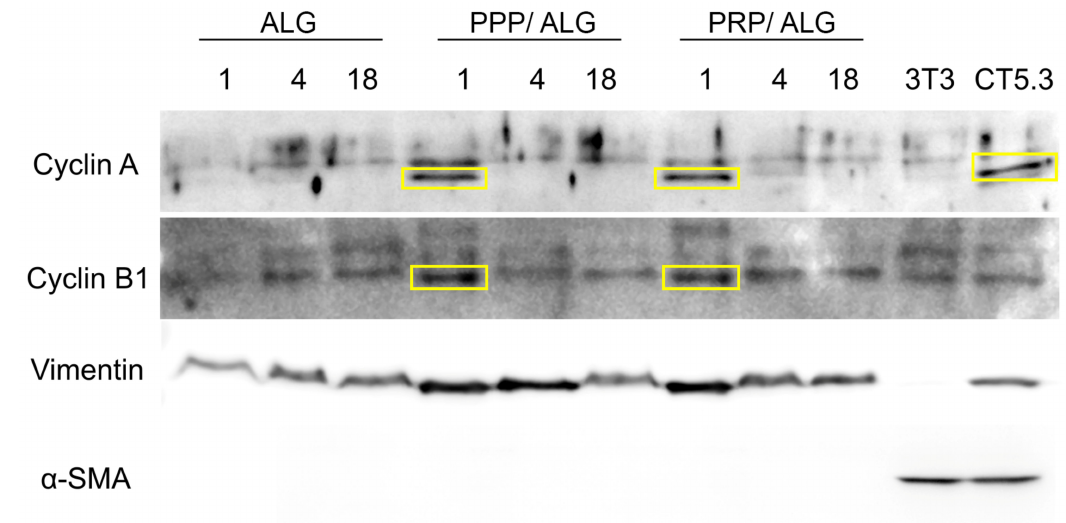
Figure 6. Western blot analysis of protein expression in pristine ALG-, PPP/ALG-, and PRP/ALG-dressing-embedded dermal fibroblasts over time (days 1, 4, and 18). Analysis of the expression of the proliferation markers cyclins A and B1 and the cytoskeletal proteins vimentin and α -SMA. An equal amount of protein was loaded in each lane. Protein extracts of NIH3T3 fibroblasts and CT5.3 colon cancer-associated fibroblasts were used as controls. ALG, alginate; PPP, platelet-poor plasma; PRP, platelet-rich plasma; α -SMA, smooth muscle α